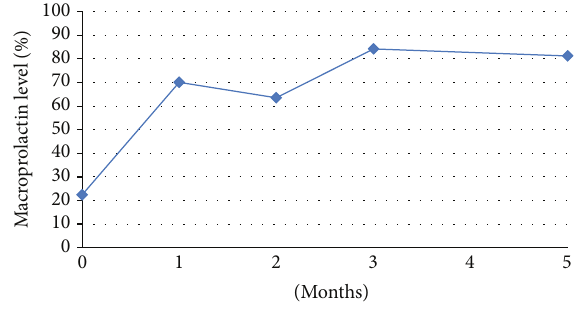
Figure 2: Macroprolactin